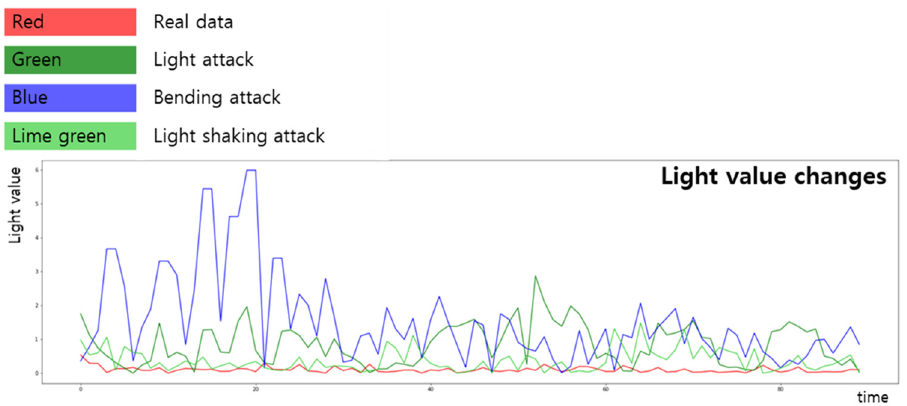
Figure 4. Light value changes according to time domain.